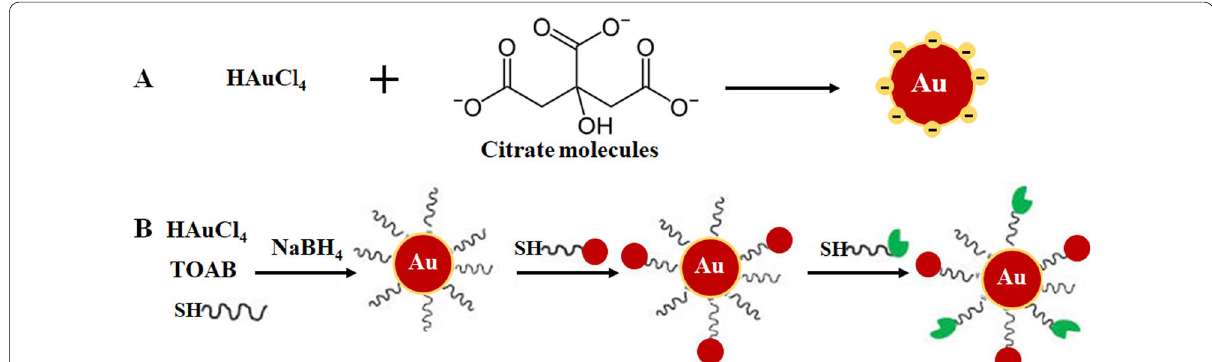
Fig. 1 AuNP formulation through one-phase system by citrate reduction ( A ) and two-phase system reduction followed by stabilization and functionalization via ligand exchange reaction, Brust–Schiffrin method ( B ). Reproduced with permission [36]. Copyright 2013, De Gruyter. TOAB tetrabutylammonium bromide, SH thiolated